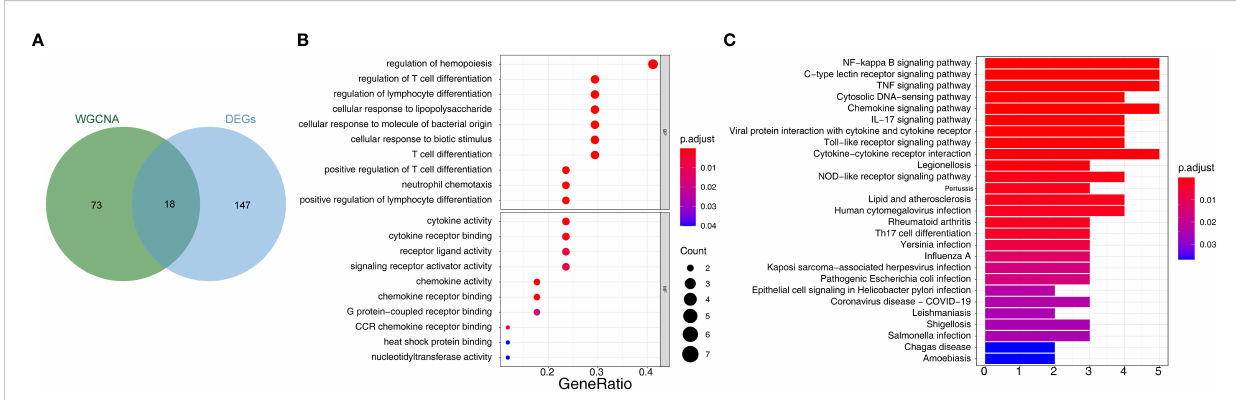
FIGURE 3 Identi fi cation of 18 common 28 bariatric surgery-related genes and functional enrichment analysis of these genes. (A) The Venn diagram of 18 common genes 28 key biological indicators between 91 hub genes and 165 DE-mRNAs. (B) Gene Ontology (GO) enrichment analysis of bariatric surgery-related genes. (C) Kyoto Encyclopedia of Genes and Genomes pathway (KEGG) enrichment analysis of bariatric surgery-related